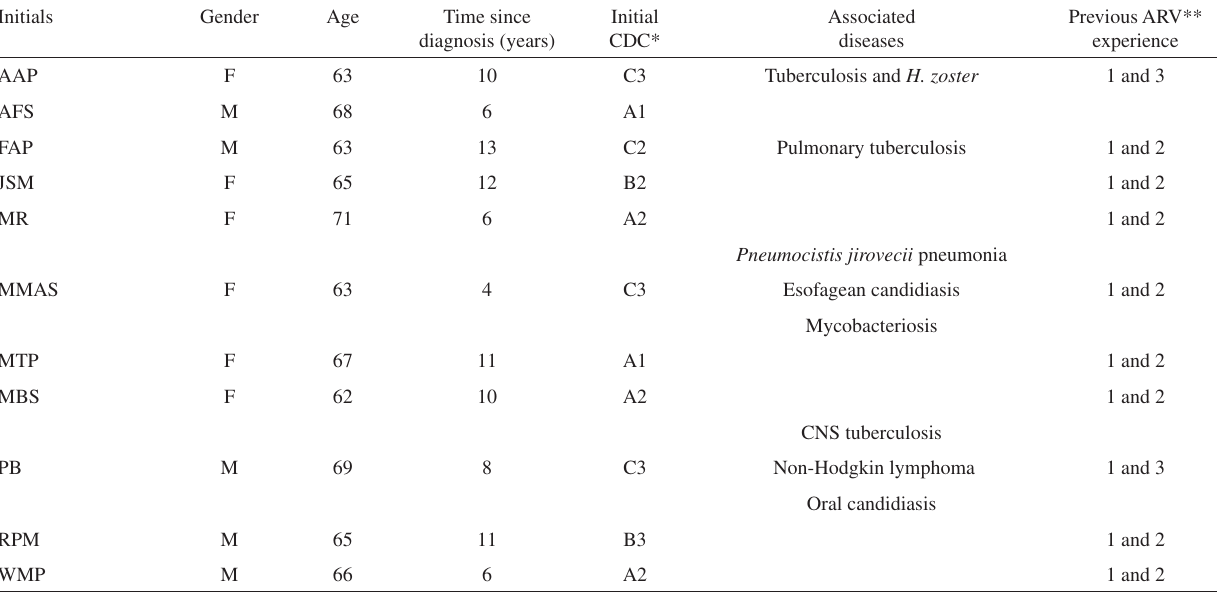
Table 1 - Baseline demographic and clinical characteristics of the analyzed